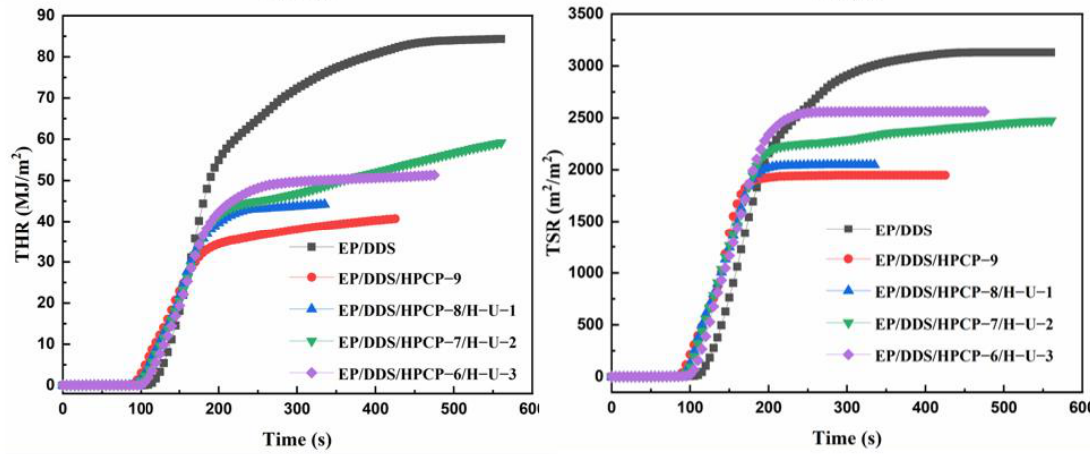
Figure 9. Plots of HRR ( a ), THR ( b ), SPR ( c ), and TSR ( d ) versus time of EP and its composites.